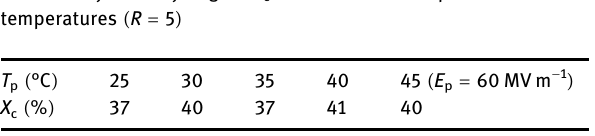
the samples after stretching and heated - poling ( Figure 6 ( b )) . Table 5: Crystallinity degree X